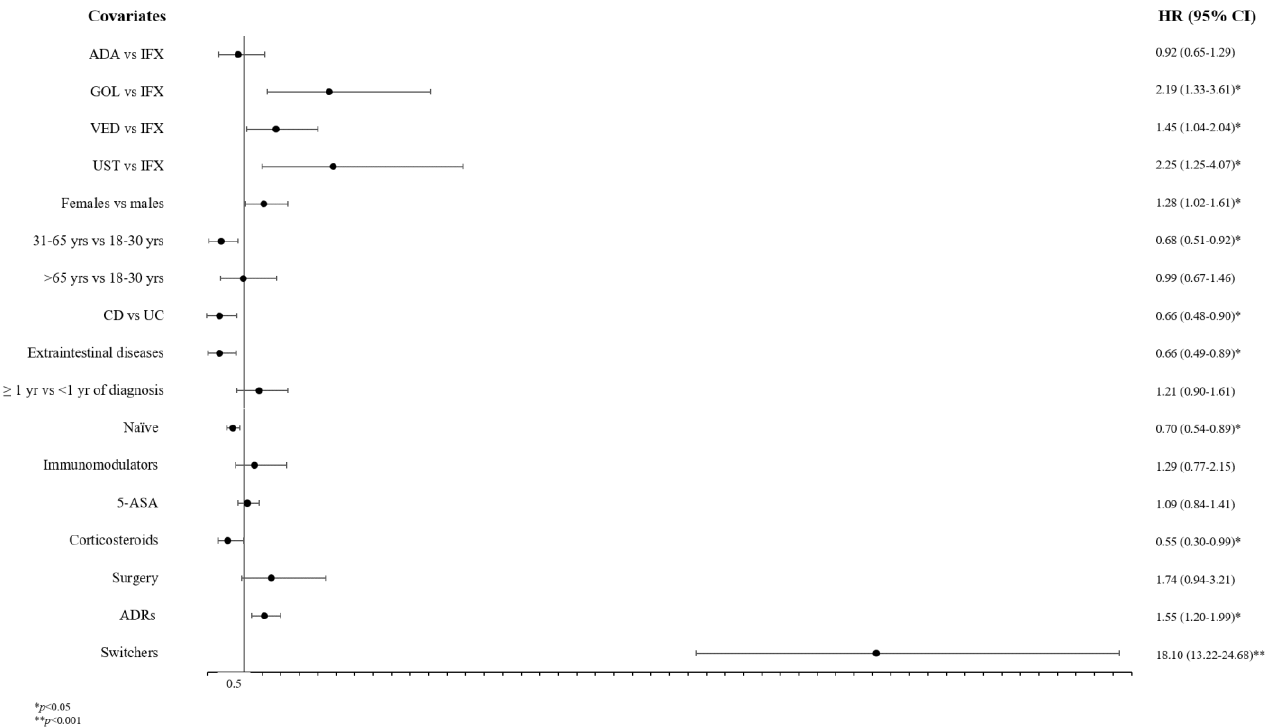
Figure 2. Predictors of non-persistence of biologics in patients with IBD. Abbreviations: 5-ASA = mesalazine; ADA = adalimumab; ADRs = adverse drug reactions; CD = Crohn’s disease; GOL = golimumab; IFX = infliximab; VED = vedolizumab; UC = ulcerative colitis; UST = ustekinumab; yrs = years.